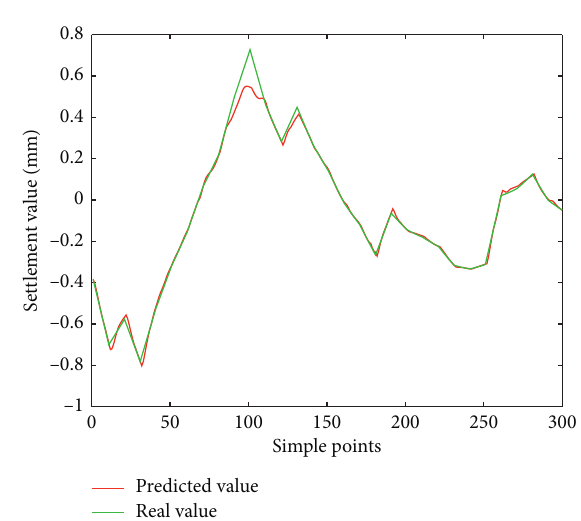
Figure 9: Random term prediction result.